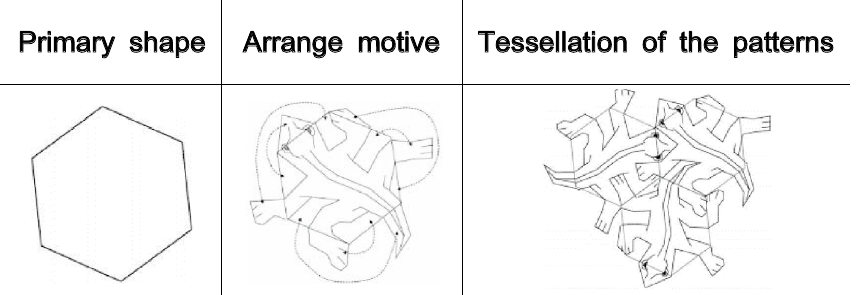
Table 4 Escher’s tessellation of the